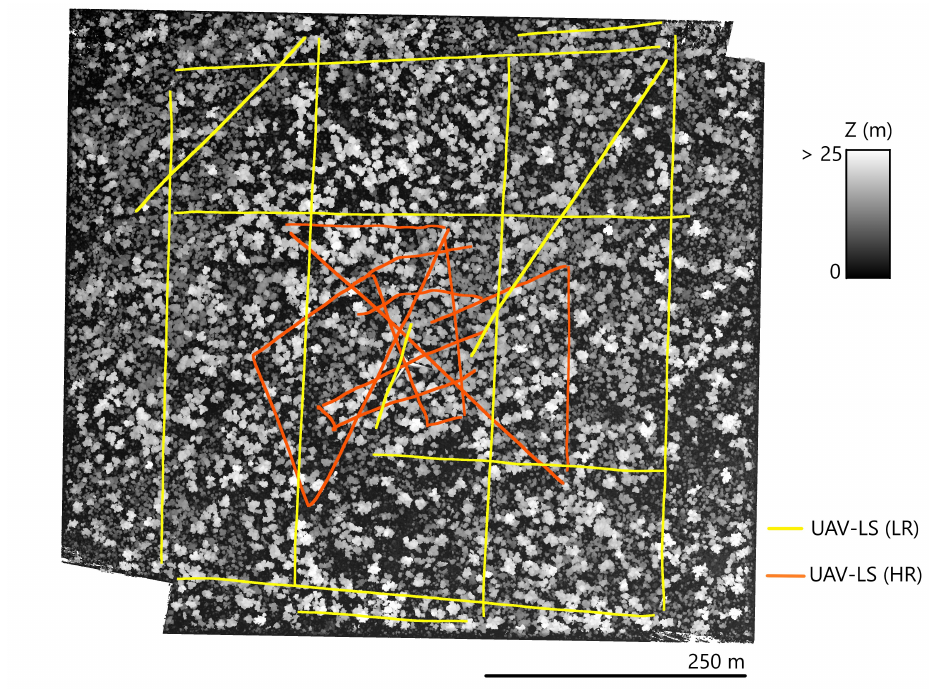
Figure A1. UAV-LS (LR) point cloud. The colour code represents the height above the terrain. The lines represent the recorded flight lines of F1 (UAV-LS (HR)) and F2 (UAV-LS (LR)). Only sections of the flight lines that were used in the registered point clouds are